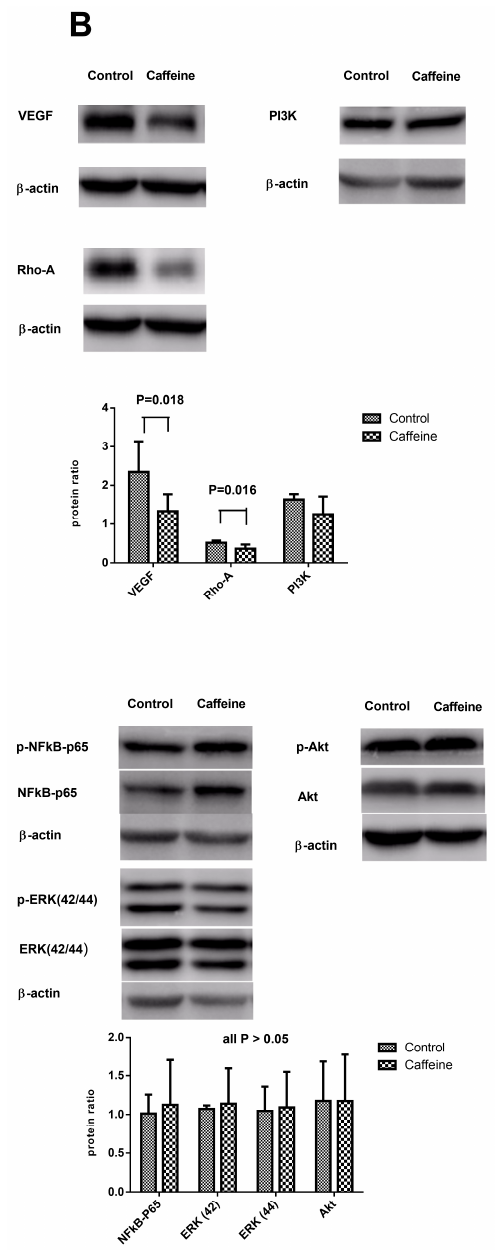
Figure 1. ( A ) Liver histology and immunochemical staining of common bile duct ligation (CBDL) rats treated by caffeine or distilled water ( control ). The representative hematoxylin and eosin (H&E) staining image of control CBDL rats shows ballooning change of hepatocytes accompanied by many inflammatory cells ( green arrow ), indicating the inflammatory change of liver (magnification 100x, upper panel). Liver fibrosis is demonstrated by Sirius red staining (magnification 40x, green arrow indicating red area, middle panel ). As compared with the control group, caffeine significantly attenuates liver fibrosis ( middle panel ). In addition, many CD31-positive staining cells ( green arrow indicating brown cells) are noted in the control group, which is attenuated by caffeine (magnification 200x, lower panel ). ( B ) Hepatic protein expressions of caffeine-treated and control CBDL rats. The densitometric quantification and representative Western blots of VEGF and Rho-A kinase, but not PI 3 K, protein expressions are significantly down-regulated by caffeine treatment (VEGF, p = 0.018, Rho-A kinase, p = 0.016, upper panel ). The phosphorylated-NF- κ B p65, phosphorylated-ERK (42/44), and phosphorylated-Akt protein expressions are not significantly influenced by caffeine (all p > 0.05; lower panel). The representative Western blots are